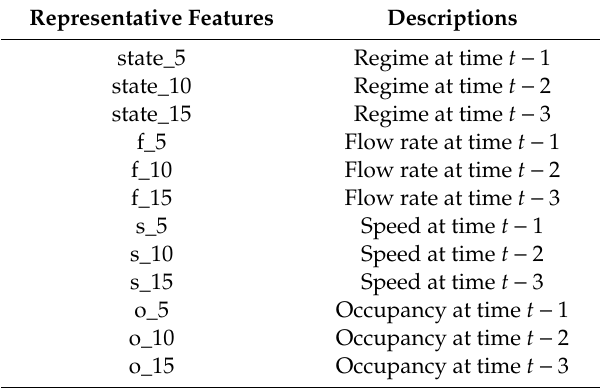
Table 1. Constructed features for forecasting